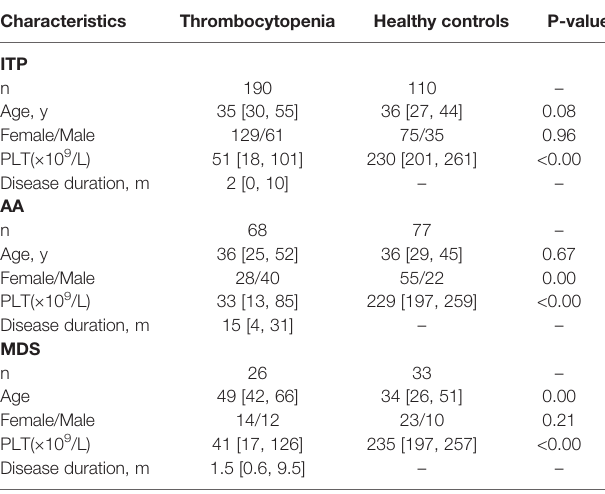
TABLE 1 | Demographic and clinical characteristics in entire thrombocytopenia cohort and healthy